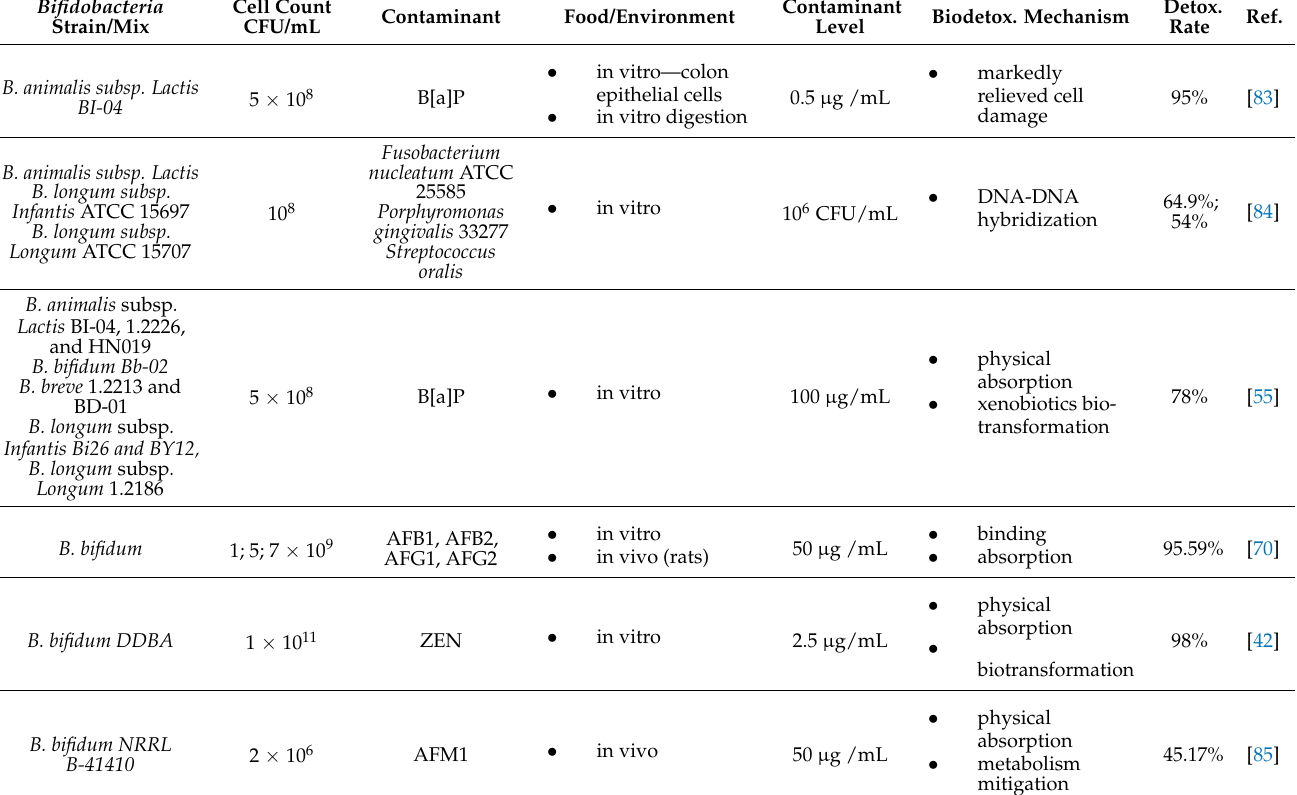
Table 2. Bifidobacteria strains, their biodetoxification mechanisms, and rates for different food